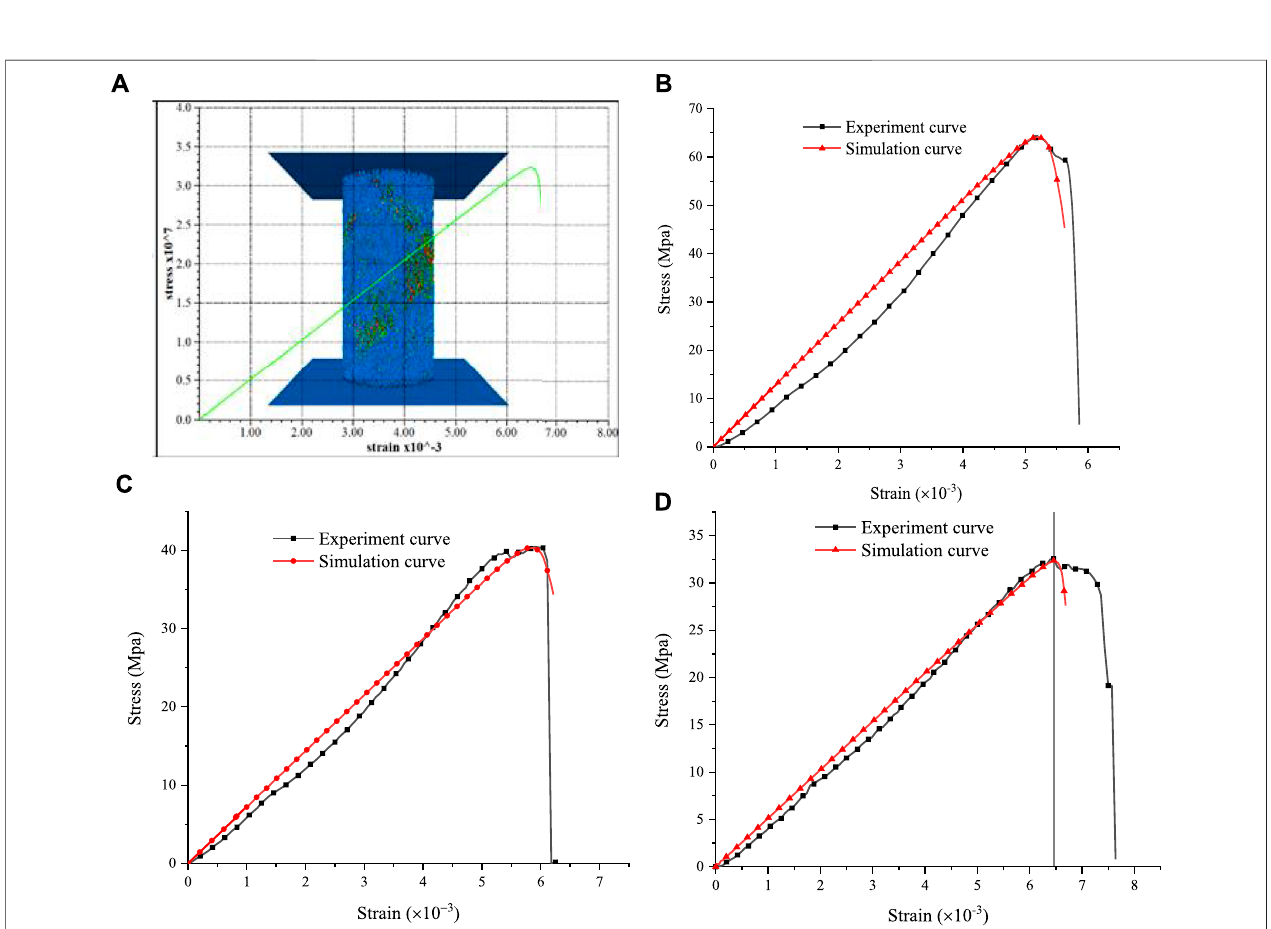
FIGURE4 | Calibration curve ofthe specimen. (A) PFC calibration model; (B) calibration curvesof dry specimens; (C) calibrationcurvesof natural specimens; and (D) calibration curve of the saturated specimen.